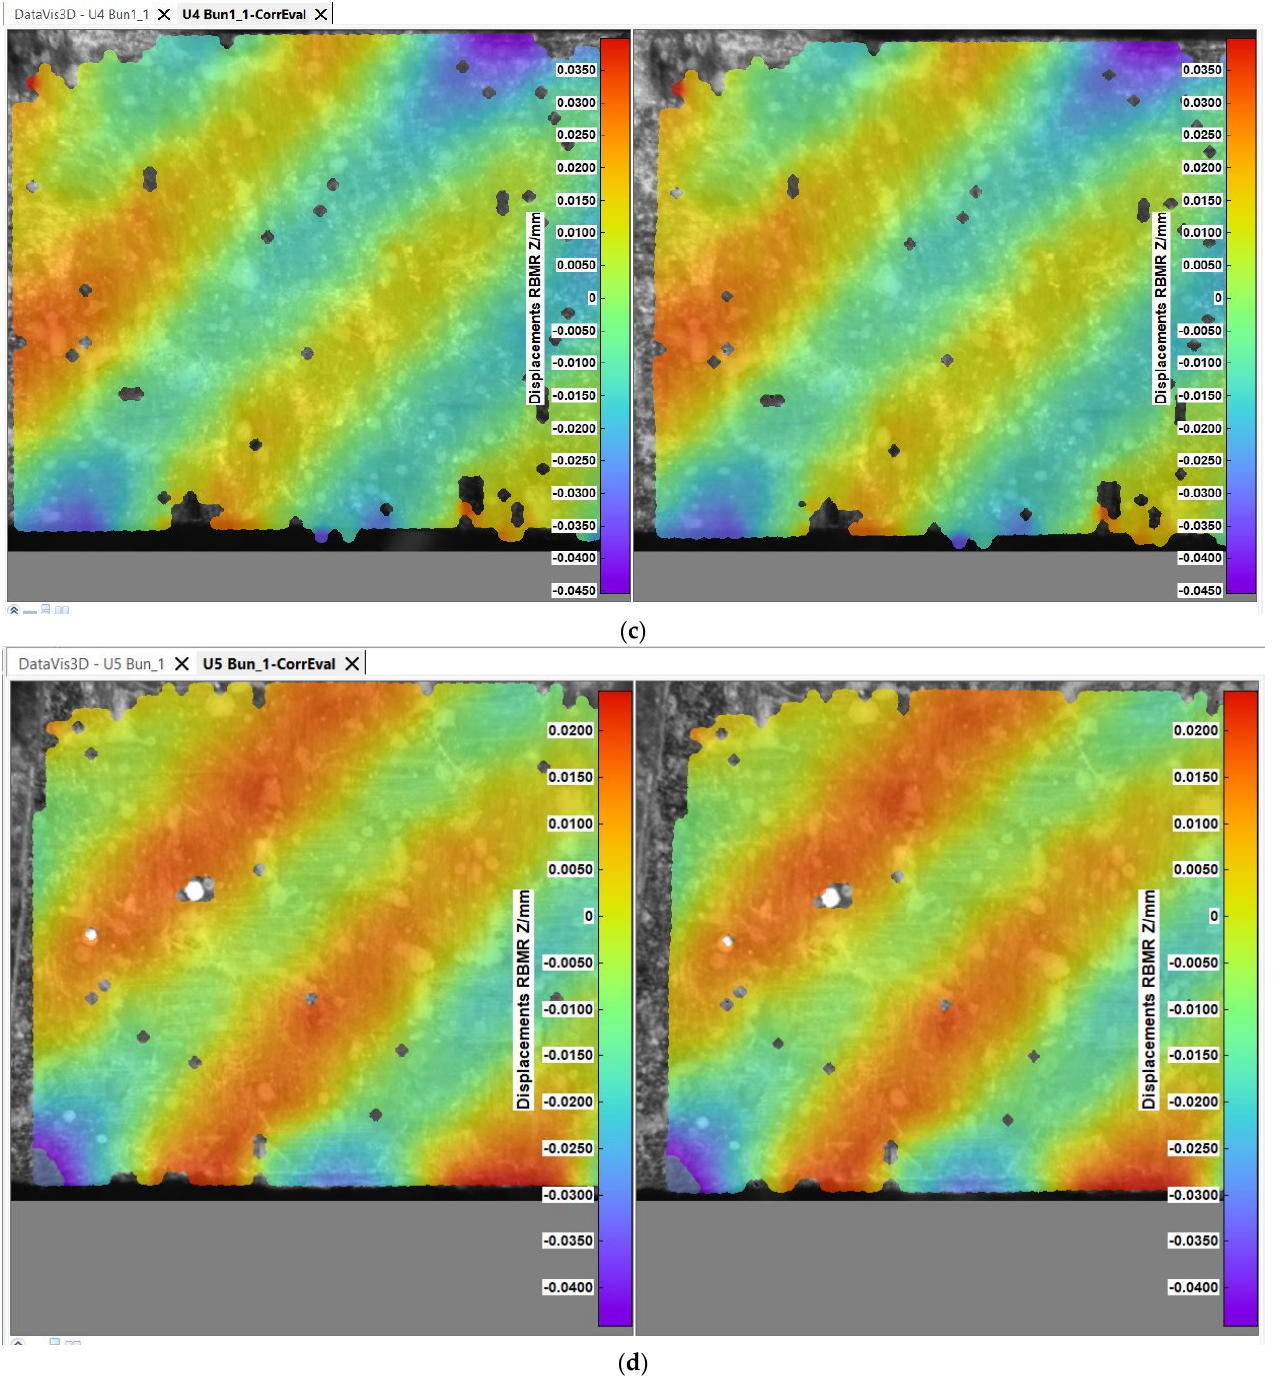
Figure 7. Displacements on Z direction for the single-ply test specimens—( a ) B 2 specimen, ( b ) B 5 specimen, ( c ) U 4 specimen, ( d ) U 5 specimens—test time 180 s. specimen, ( c ) U 4 specimen, ( d ) U 5 specimens—test time 180